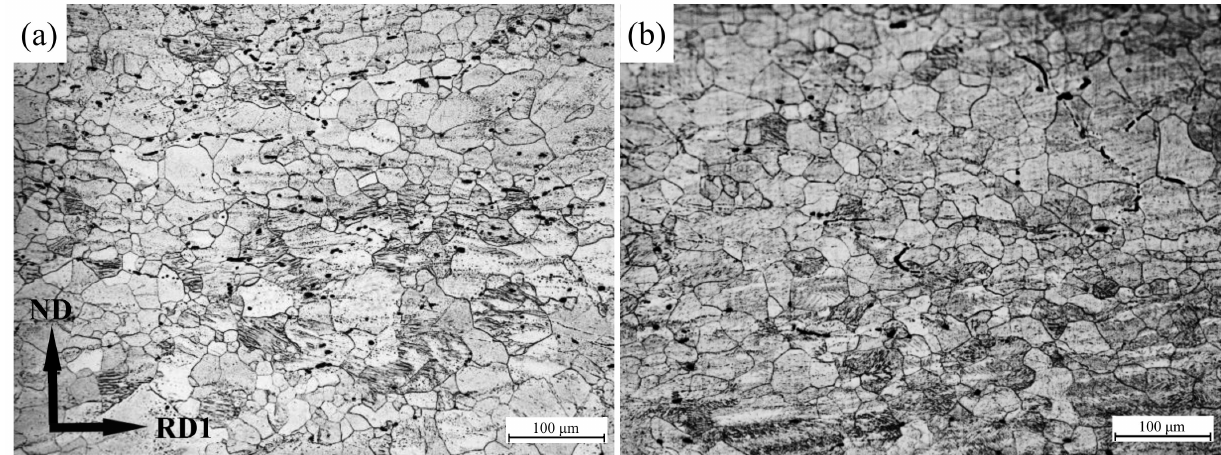
Figure 10. Optical micrographs of ( a ) as-rolled and ( b ) as-annealed pure Mg